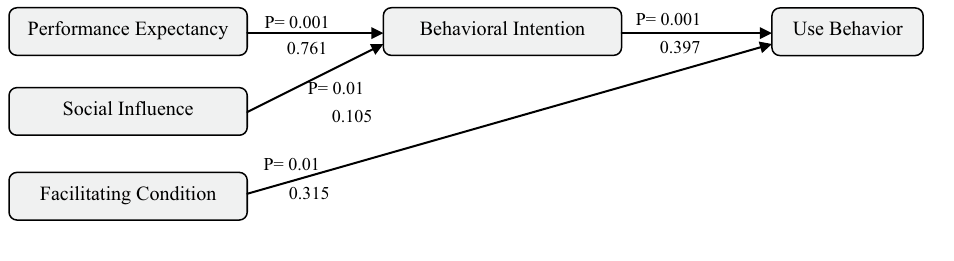
Fig. 4 Measurement model